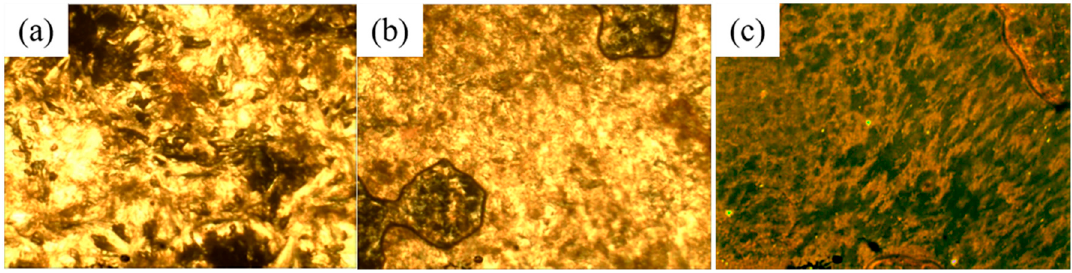
Figure 3. The texture images of PSCTLCP observed by POM at ( a ) 170, ( b ) 210, and ( c ) 275 °C.